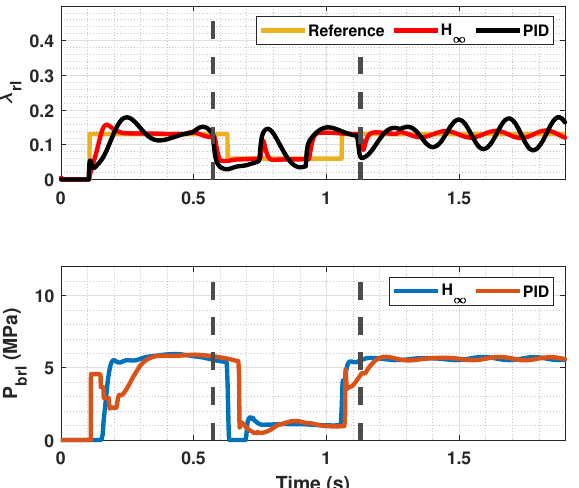
Figure 15. Rear wheels tire slip, reference tire slip and brake pressure for changing µ max .